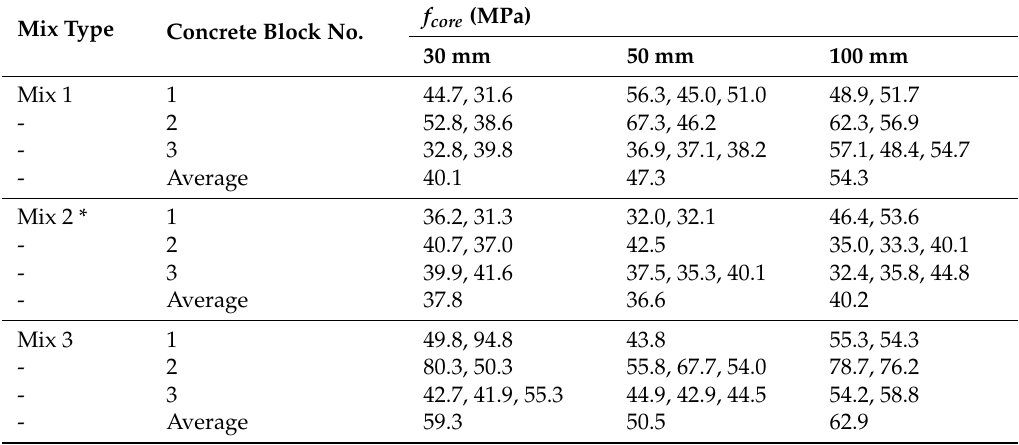
Table 8. Compressive core strength of concrete according to the mix types and core